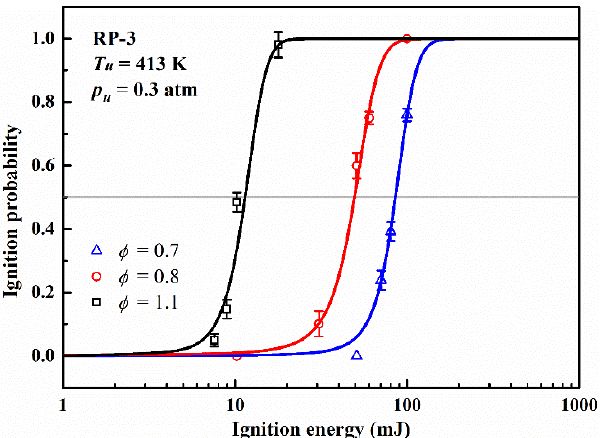
Figure 6. Effects of equivalence ratio on the ignition probability. ( T u = 413 K, p u = 0.3 atm, Z H2O = 0%, Z O 2 = 21%).